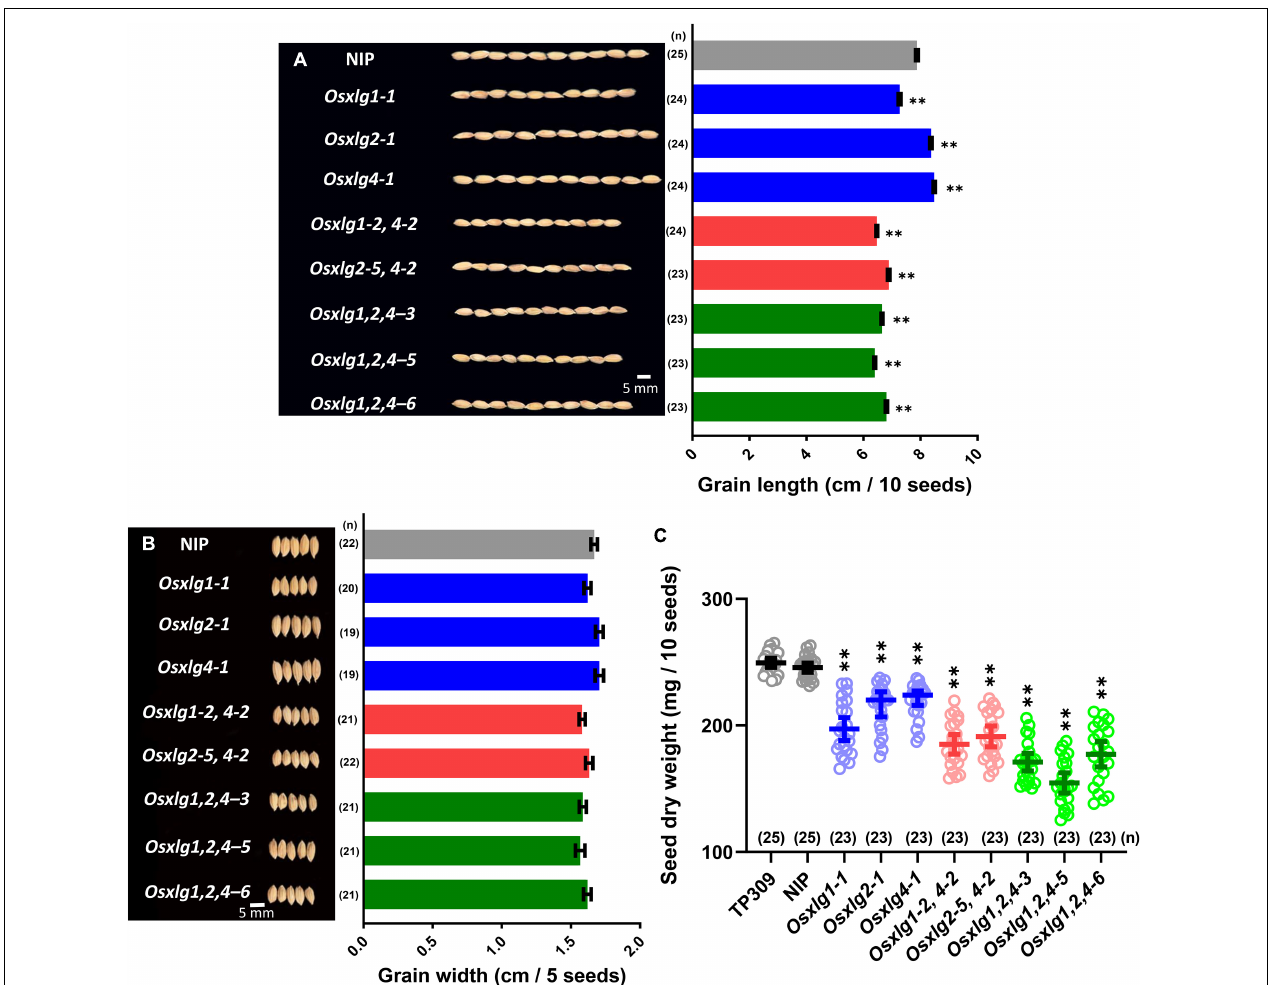
FIGURE 3 | Rice seed phenotypes and dry weight in Osxlg mutants. Grain and grain length (A) , grain width (B) , and seed dry weight (C) , of WT cv. Nipponbare (NIP) and Taipei (TP309) and Osxlg single, double, and triple mutant plants. Each data point represents raw value of 10 seeds’ weight, the horizontal lines indicate the means, and the error bars represent 95% confidence intervals. Oryza sativa L. japonica cv. Taipei 309 (TP309) was used as an additional control. The sample size was shown as ( n ). Statistical analysis was done using one-way ANOVA followed by Tukey’s multiple comparison test, ∗∗ p < 0.001 by comparing WTNIP with Osxlg mutants. Bar = 5